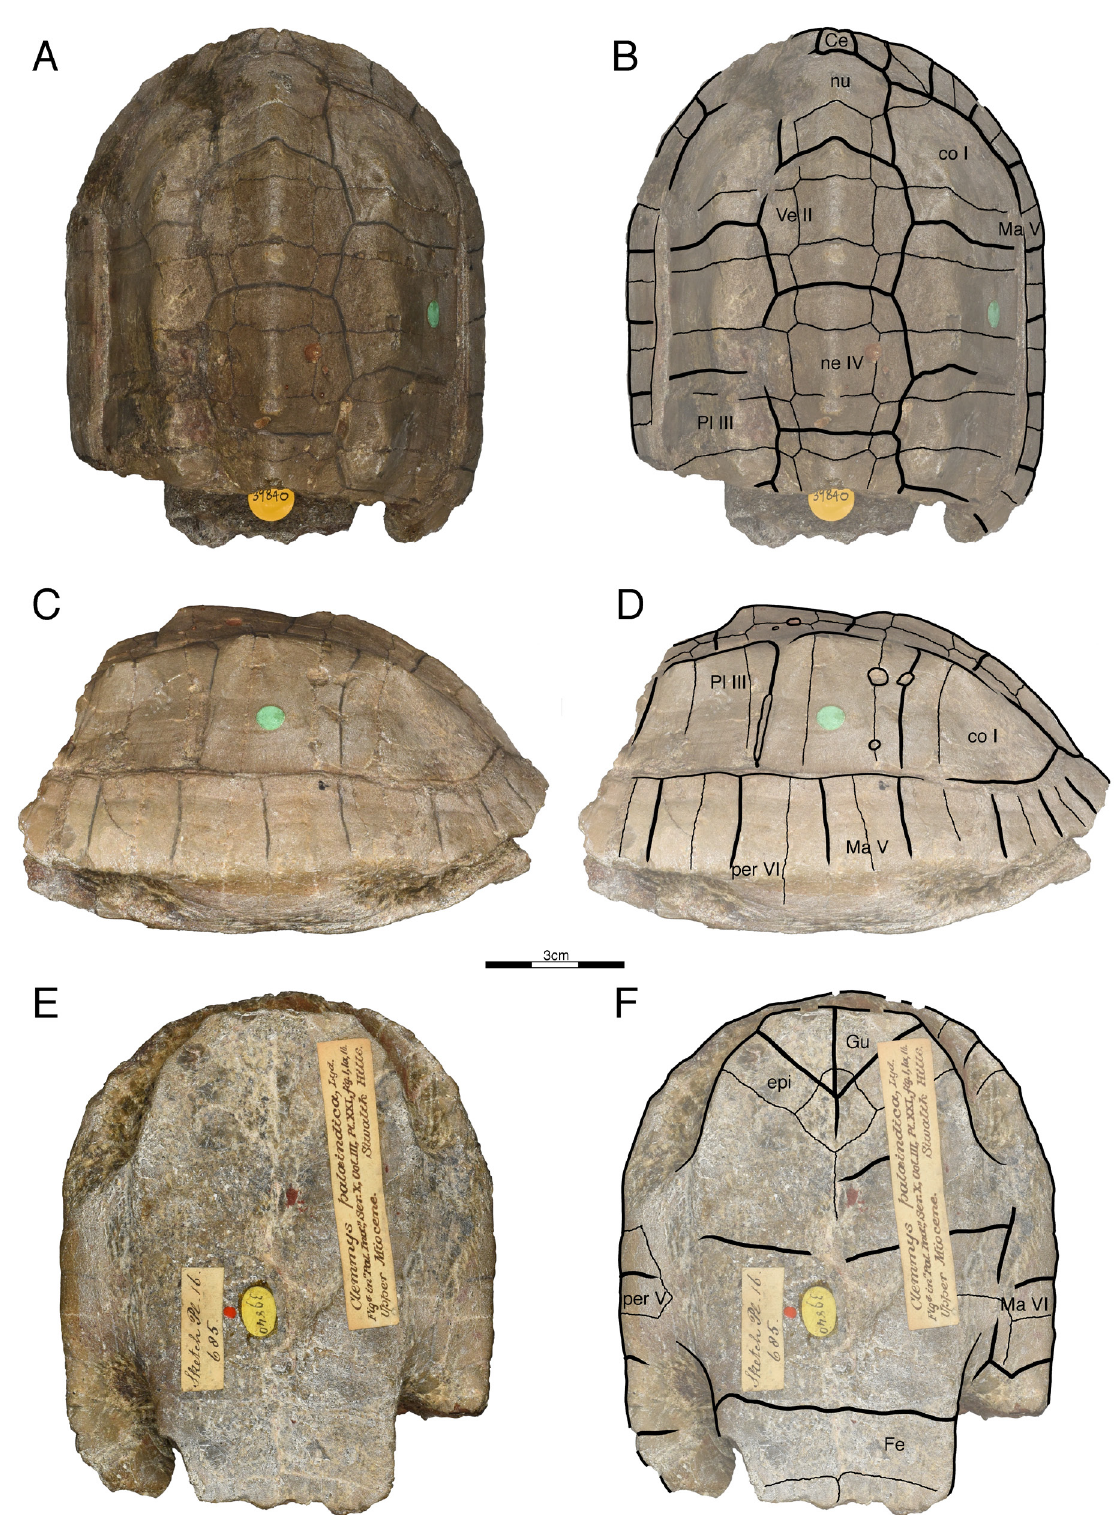
Fig. 23. BMNH 39840, referred to Clemmys palaeindica Lydekker, 1885, here identified as Geoclemys hamiltonii (Gray, 1830). A . Photograph of carapace. B . Illustration of carapace. C . Photograph of carapace in lateral view. D . Illustration of carapace in lateral view. E . Photograph of plastron. F . Illustration of plastron. Scale bar: 3